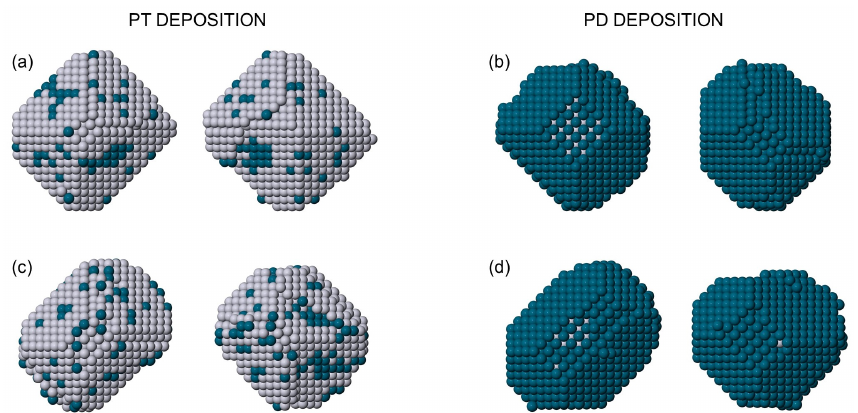
Figure 4. Representative growth structures of size 1500. ( a , b ) Structures obtained in growth simula- tions at 800 K for Pt and Pd deposition, respectively. ( c , d ) Elongated structures obtained in growth simulations at 900 K for Pt and Pd deposition, respectively. Each structure is shown from two per- spectives. Here and in the following, Pt and Pd atoms are represented in gray and blue, respectively.